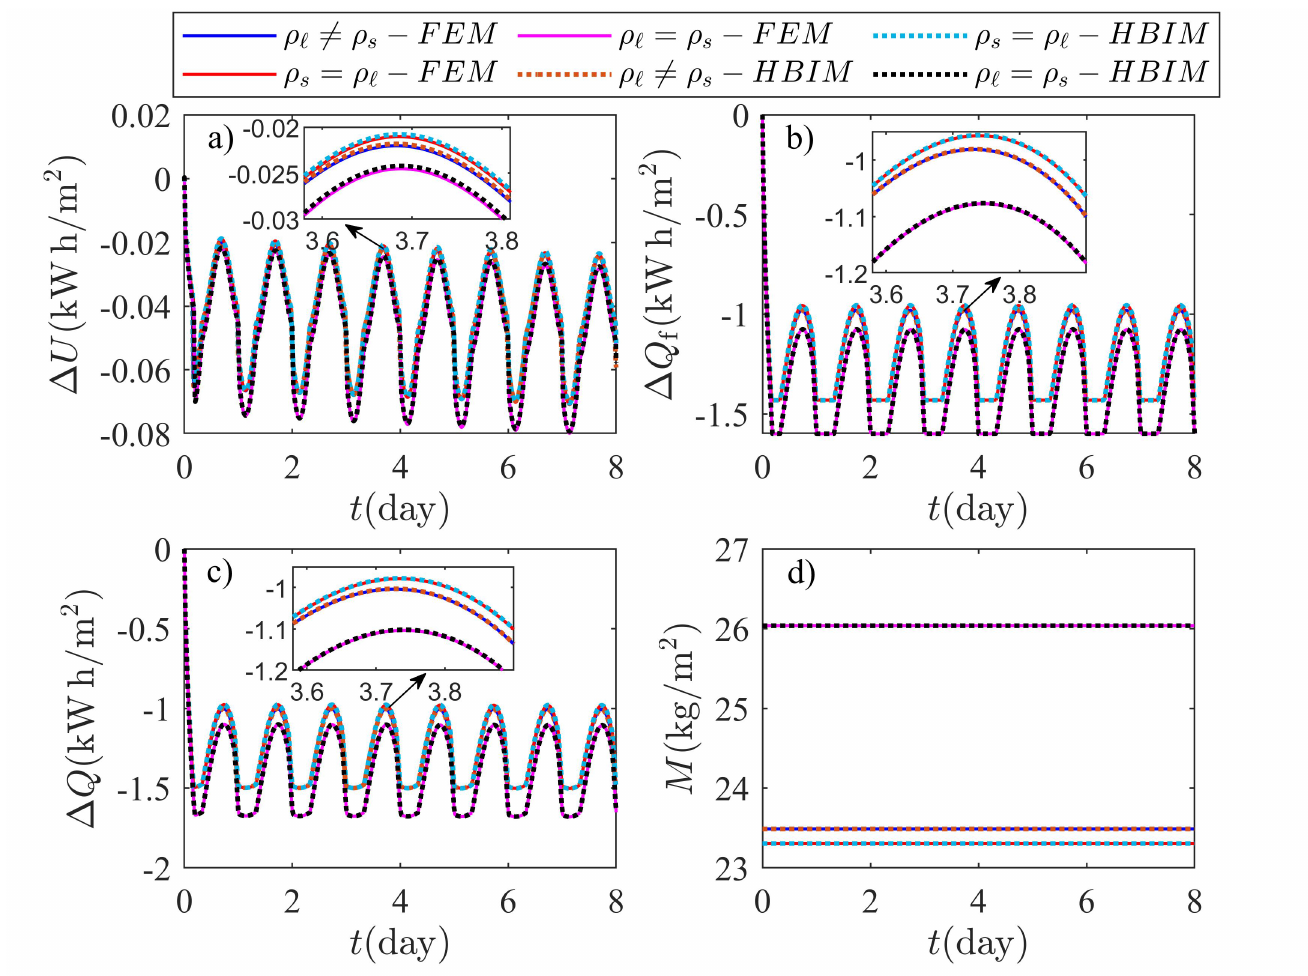
Figure 11. Time evolution of ( a ) internal energy change ∆ U , ( b ) latent heat released (absorbed) ∆ Q f , and ( c ) total energy changes ∆ Q per unit area in kWh/m 2 according to the model proposed in this work ( ρ s (cid:54) = ρ (cid:96) ) and the constant volume method used by other authors ( ρ s = ρ (cid:96) or ρ (cid:96) = ρ s ) [21,23–25]. ( d ) Time evolution of total mass is registered to verify that mass is not created or destroyed during the transient and steady periodic regimes. The effects of volume changes on the thermal energy released (absorbed) during solidification, melting, front formation and collision are discussed in Section